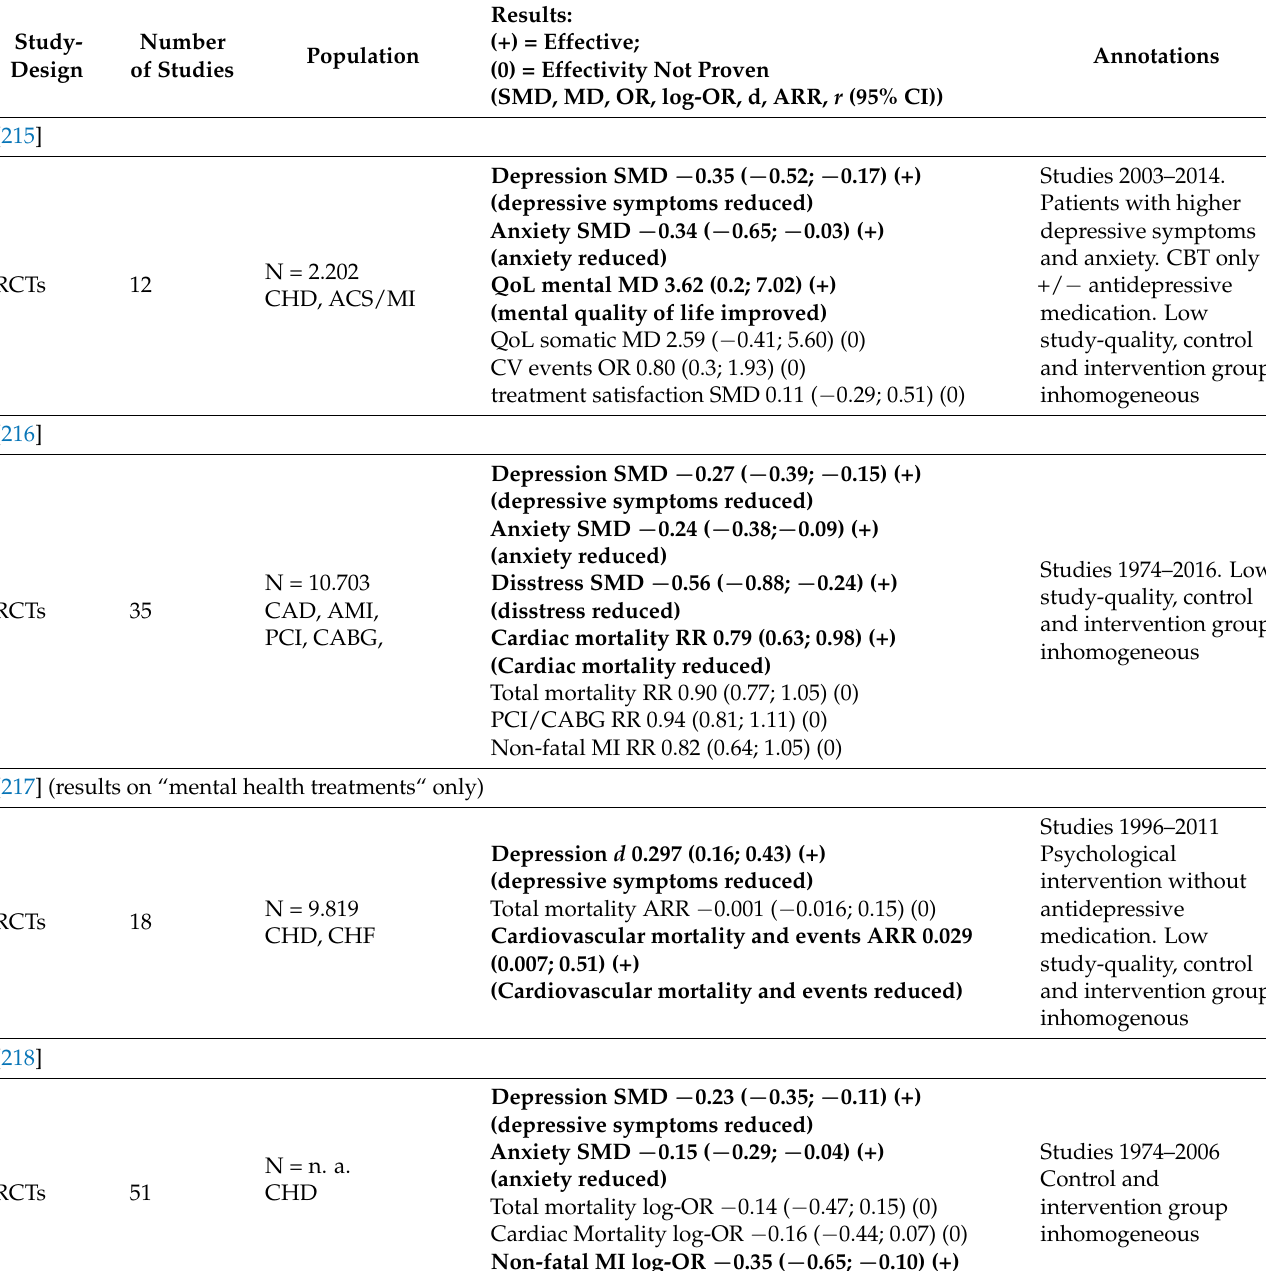
Table 5. Meta-analyses until 2018 on psychological intervention in cardiovascular